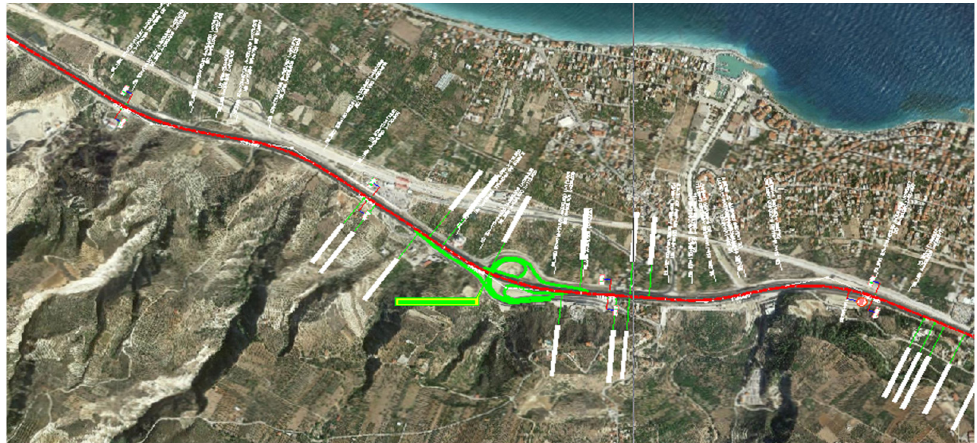
Figure 1. Extract of the developed CAD drawing.